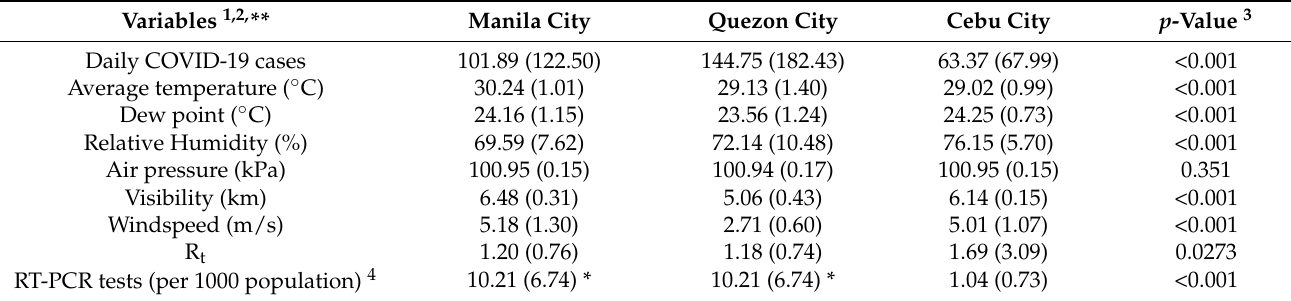
Table 1. City-specific health outcome and exposure summary statistics.